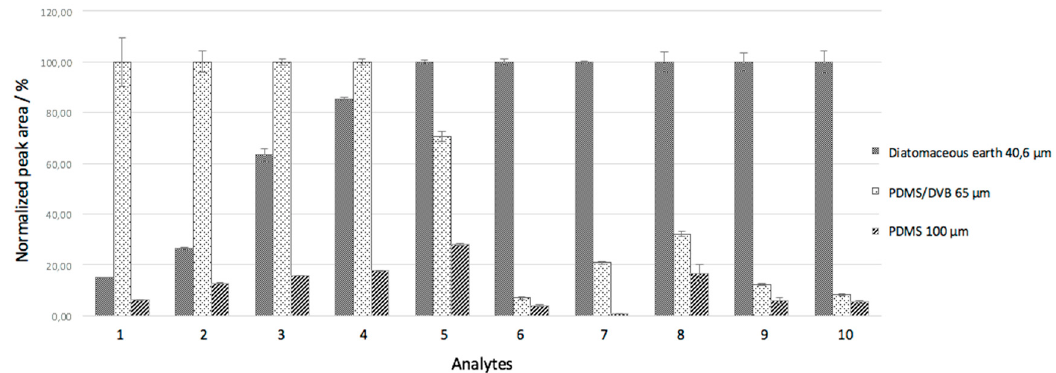
Figure 4. Comparison of extraction efficiencies of the biosorbent fiber, PDMS/DVB and PDMS coatings for determination of PAHs. Analytes: (1) acenaphtlylene; (2) fluorene; (3) phananthrene; (4) anthracene; (5) pyrene; (6) benzo[a]anthracene; (7) chrysene; (8) benzo[b]fluoranthene; (9) benzo[k]fluoranthene; and (10) benzo[a]purene.